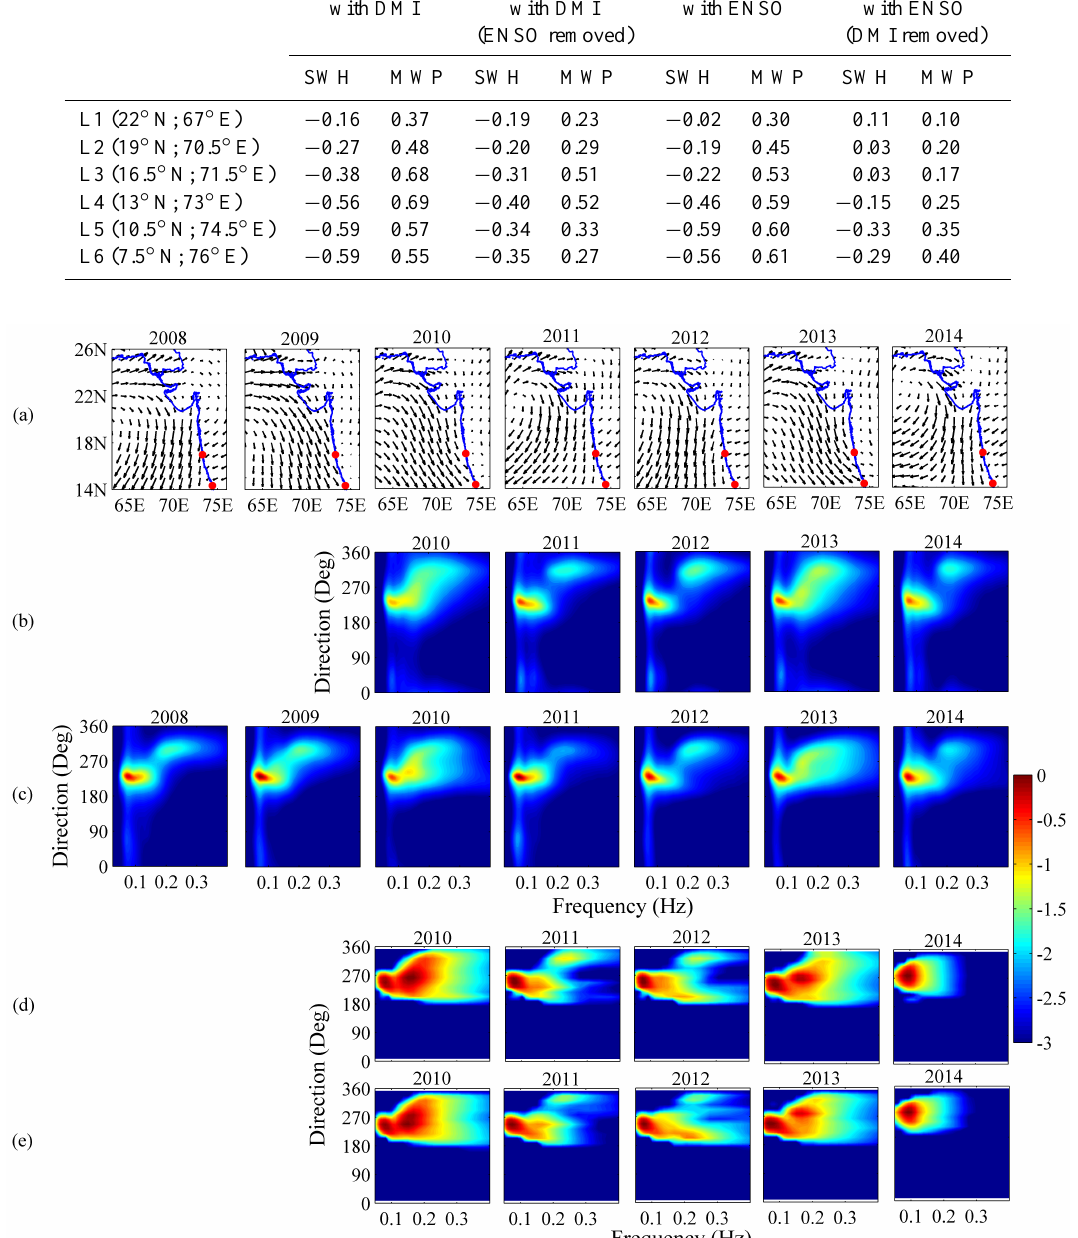
Figure 5. Averaged wind pattern of October from 2008 to 2014 (a) . Averaged measured wave frequency–directional spectra from 2008 to 2014 off Ratnagiri (b) and off Honnavar (c) . Color bar is for spectral energy (m 2 Hz − 1 Deg − 1 ). (d) Modeled directional spectrum off Ratnagiri and (e) off Honnavar from 2010 to 2014. The spectral energy is shown in logarithmic scale base 10. SST anomalies of eastern and western equatorial IO with DMI are shown in Fig.